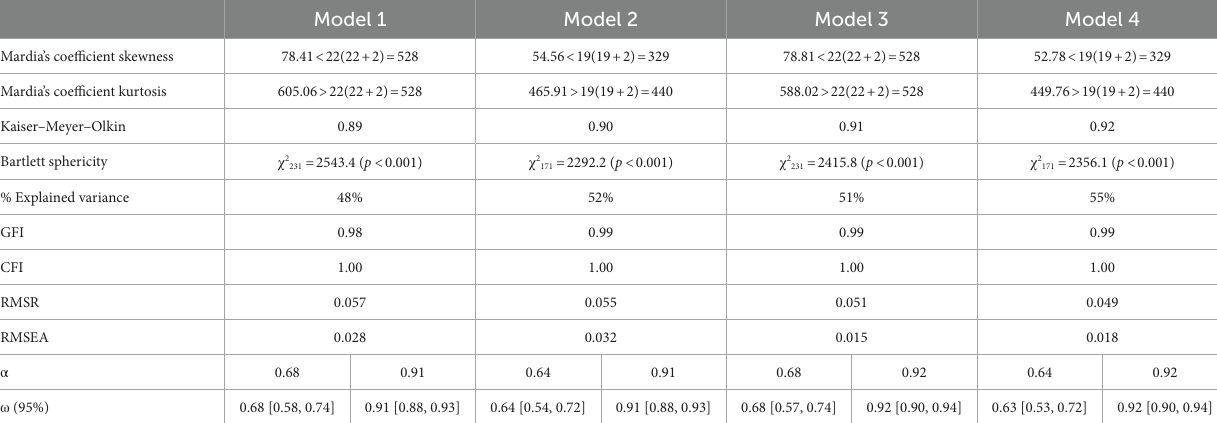
TABLE 1 Proposed bi-factorial model parameters of the